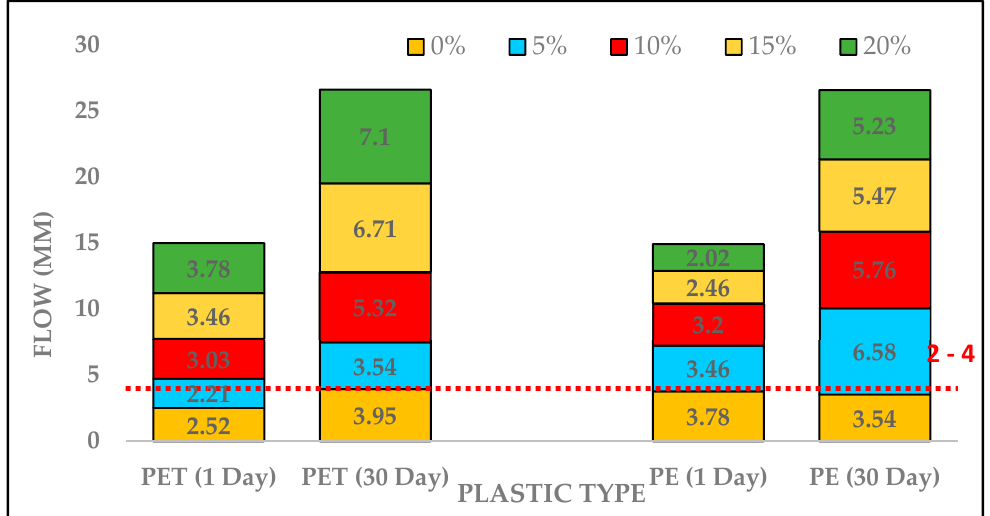
Figure 10. Flow of Plastic-Modified asphalt concrete on different testing days .